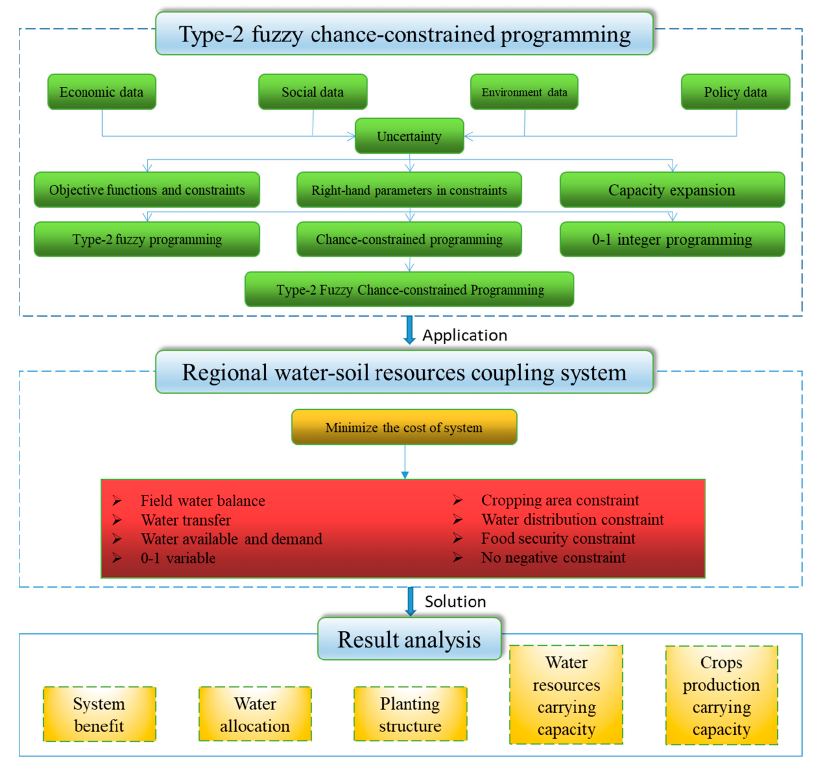
Figure 1. Decision support framework of resources and environment management for Lancang County. Table 1. Summary of research on regional water resources optimal allocation.